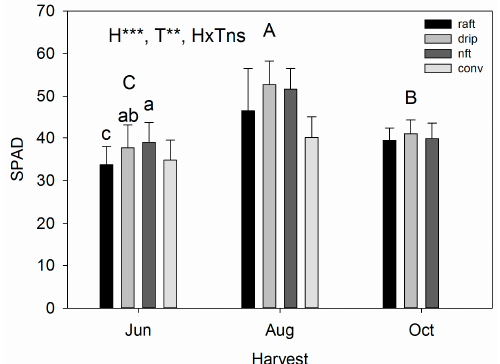
Figure 7. Comparison of leaf SPAD values between plants grown in drip irrigation, raft culture, nutrient film technique (NFT) and a commercial system; n = 3. Error bars represent standard deviation. Different uppercase and lowercase letters indicate significant differences (Tukey’s HSD, n = 3, p < 0.05) for harvests and HP systems, respectively. The factors, harvest (H) and treatment (T), and their interaction (H*T) were reported by “***” for p < 0.001 and “**” for p < 0.01.